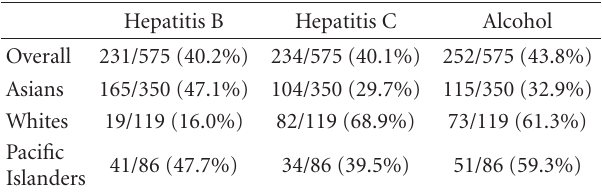
Table 1: Etiology of HCC cases 1 by